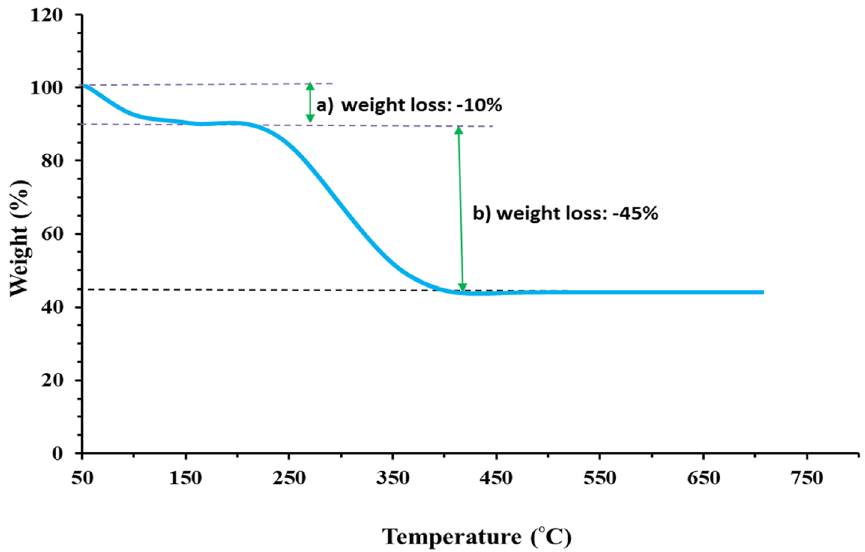
Figure 7. TGA plot of biofunctionalized CeO 2 NPs using marine oyster